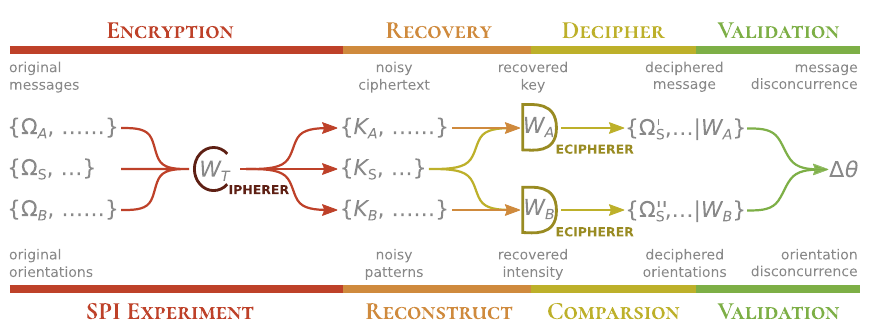
Figure 3. Analogy between ‘key-cracking’ in cryptography (text in upper rows) and validation for single particle imaging (text in lower